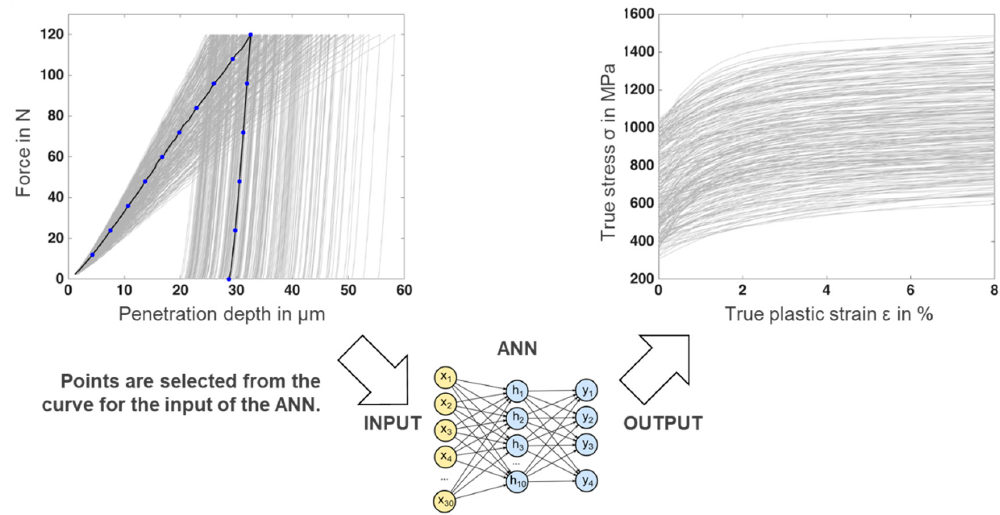
Figure 4. Force–indentation depth curves generated by the FEM model and the corresponding stress–strain diagrams as the training datasets of the ANN.